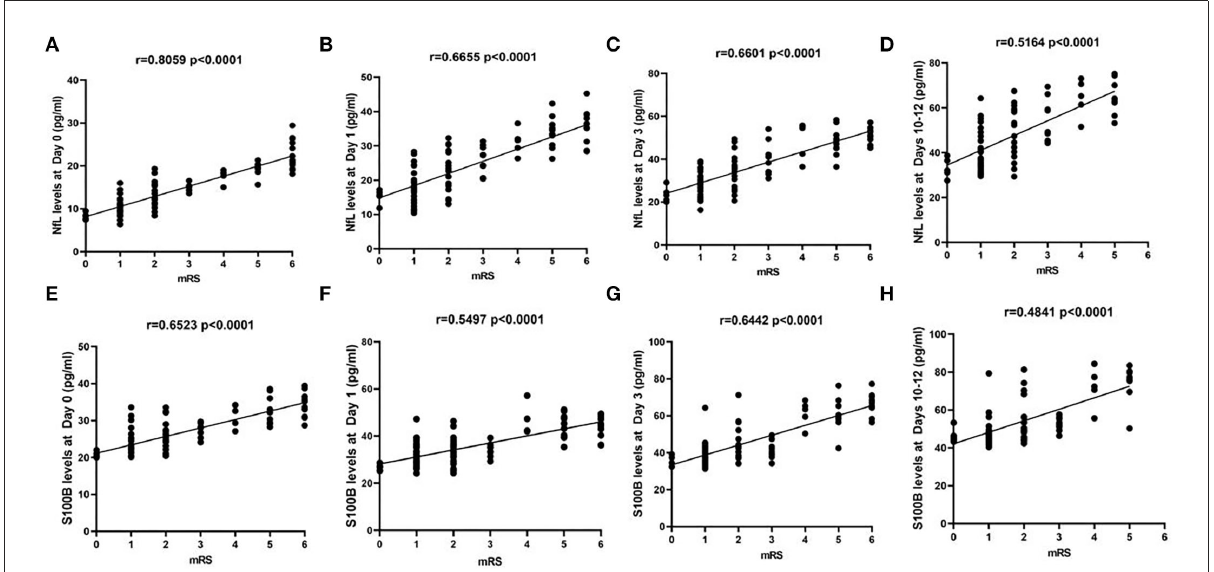
FIGURE3 (A–D) The levels of aSAH patients serum NfL (Day 0, r = 0.8059, Day 1, r = 0.6550, Day 3, r = 0.5960, and Days 10–12, r = 0.6468, respectively; P < 0.0001), (E–H) S100B (Day 0, r = 0.6530, Day 1, r = 0.5554, Day 3, r = 0.6200, and Days 10–12, r = 0.6345, respectively; P < 0.0001) were significantly correlated with modified Rankin scale scores at each time points.